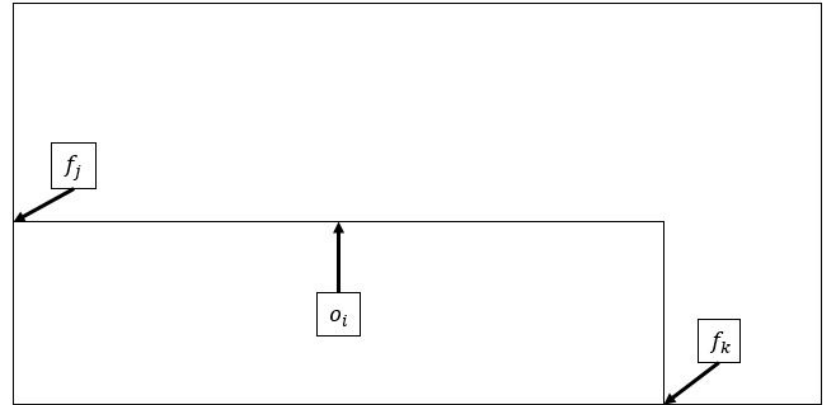
Figure 2. Flag placing; f j and f k are the new flags.